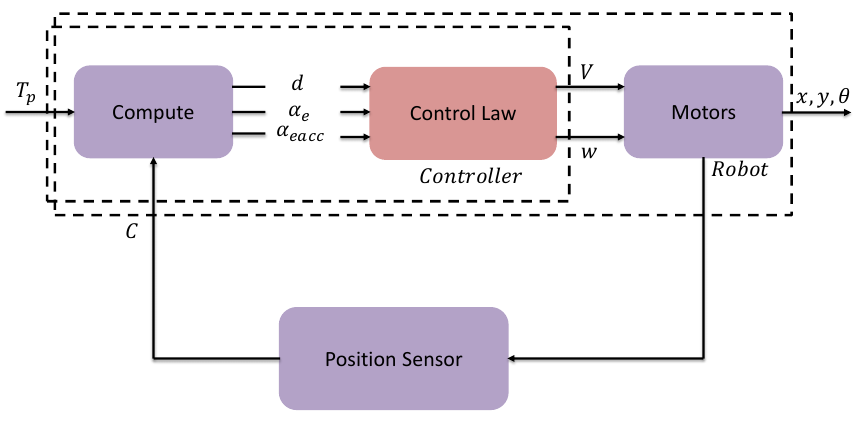
Figure 8. Control block